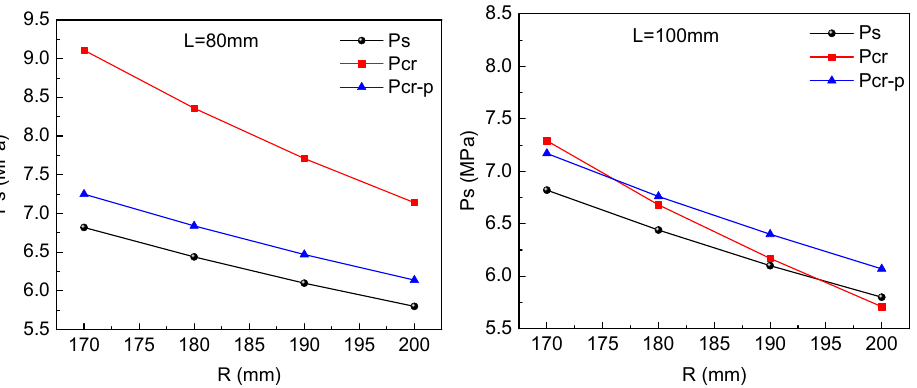
Figure 11. Effect of the initial tube diameter and length of the reducing diameter region on the critical external buckling pressure.